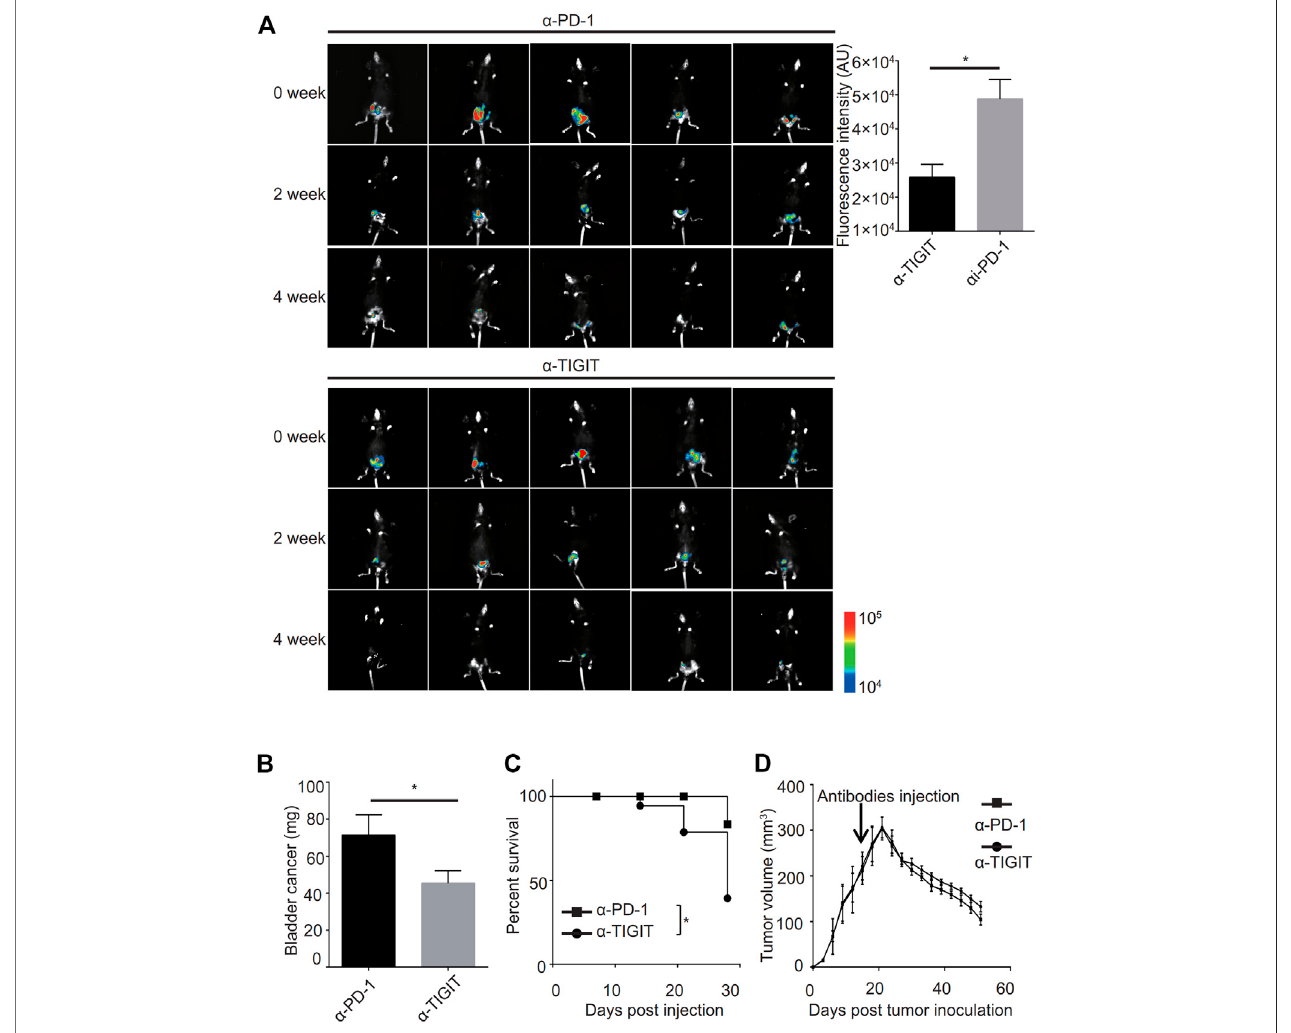
FIGURE4| TargetingTIGIT suppressed bladder cancer. (A , B) α -TIGIT suppresses bladder cancer. Invivo bioluminescent imagingofC57B6/J mice transplanted with MBT2-luciferase cells (left panel) . Bioluminescence intensities are shown as the mean ± SD. * p < 0.05; t -test. Data are representative of three independent experiments (n (cid:1) 8) (right panel) . (C) α -TIGITsuppresses thegrowth ofbladdertissues.Bladder weight ofmiceareshown asthemean ± SD. * p < 0.05; t -test. Dataare representative of three independent experiments (n (cid:1) 8). (D) Tumor-bearing mice administered α -TIGIT show a better prognosis. The relative survival rates of mice in different groups were recorded. Data are representative of four independent experiments (n (cid:1) 6). * p < 0.05; log-rank (Mantel-Cox)